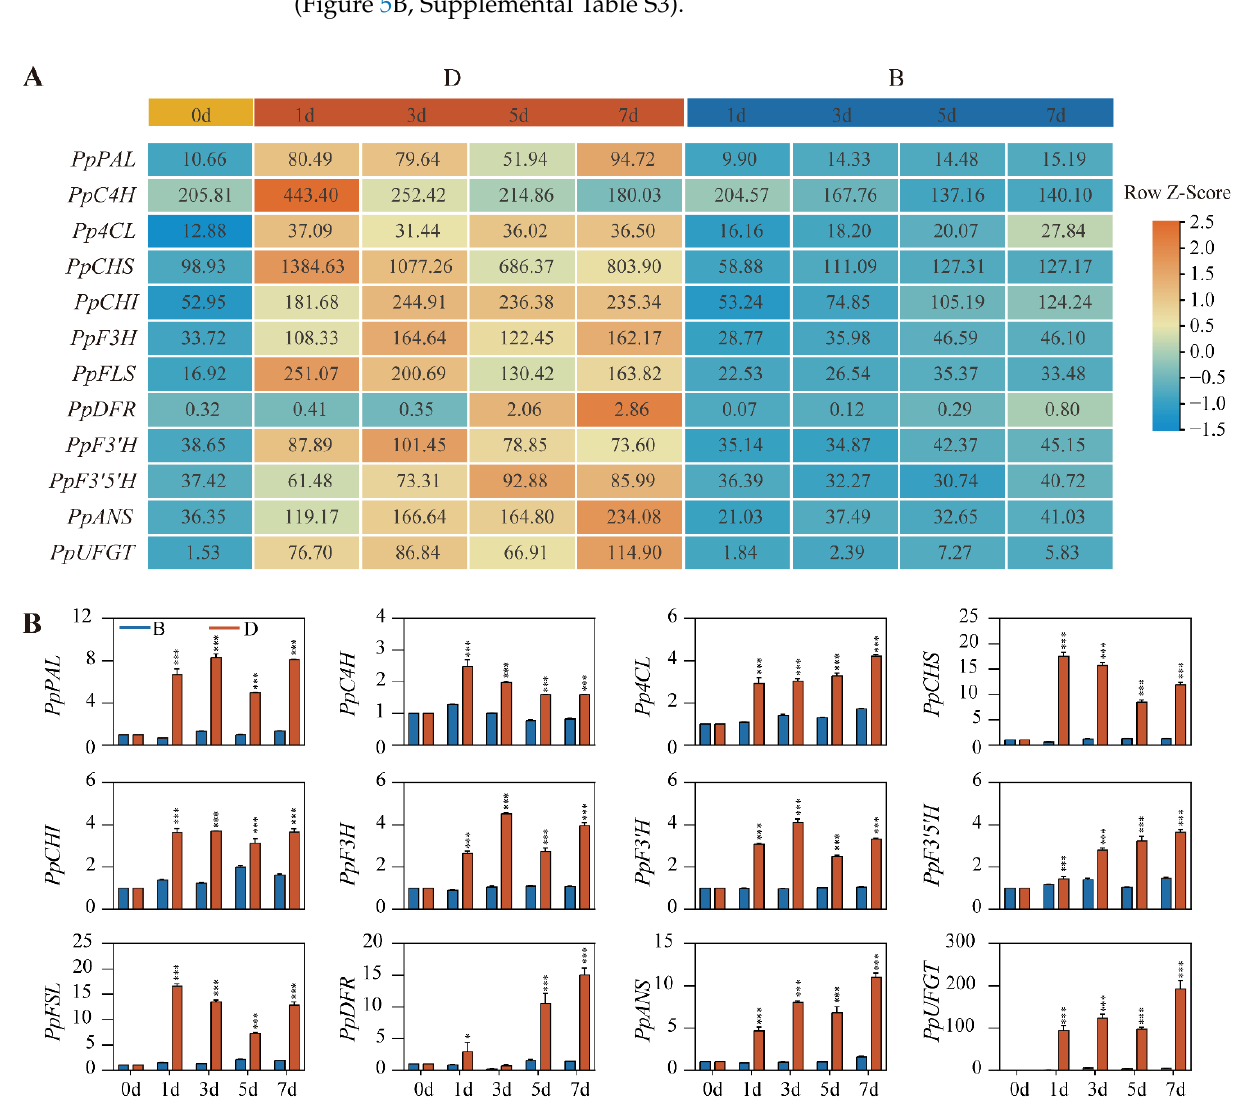
Figure 4. Expression of anthocyanin biosynthesis genes. ( A ) Heatmap illustrating the expression of anthocyanin biosynthesis genes. The numbers within the grids are original FPKM values, whereas row-scaled FPKM values are used for plotting. ( B ) Validation of gene expression by RT-qPCR. Error bars denote the standard deviations. Asterisks above the bars indicate significant differences (*** p < 0.001, * p < 0.05) obtained by two- tailed Student’s t -test within each timepoint.